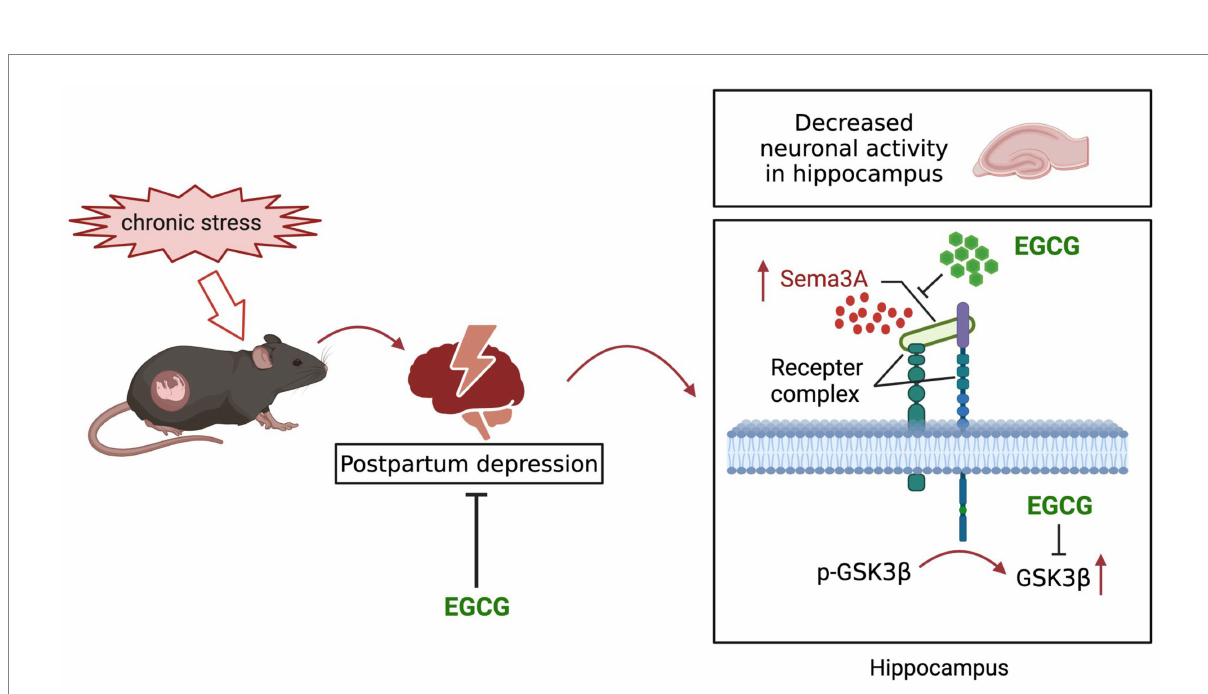
FIGURE 7 Schematic diagram of the potential mechanisms of EGCG against the anxiety and depression-like behaviors in postpartum period induced by gestational